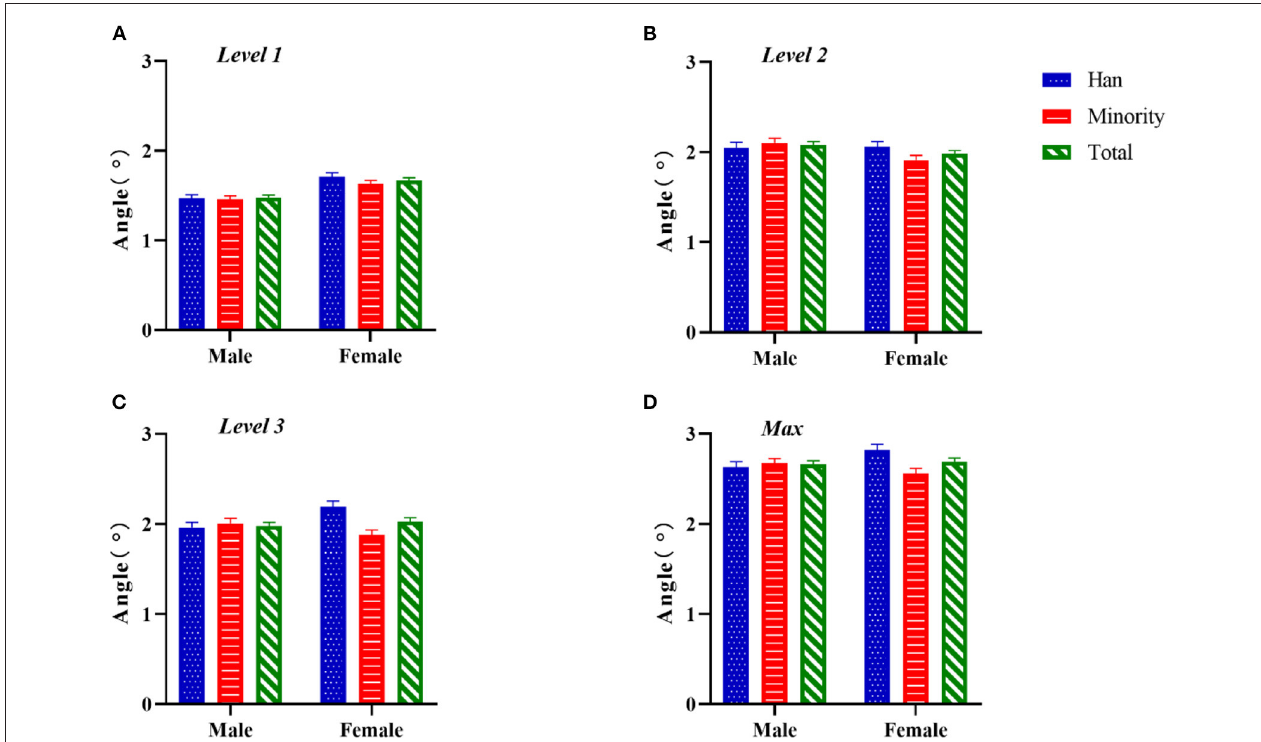
FIGURE 2 | Two-factor analysis of variance to assess differences in ATR values by ethnicity and sex. (A) Level 1, proximal thoracic (T1–T4); (B) level 2, main thoracic (T5–T12); (C) level 3, lumbar (T12–L4); (D) Max, maximum value among the three levels.